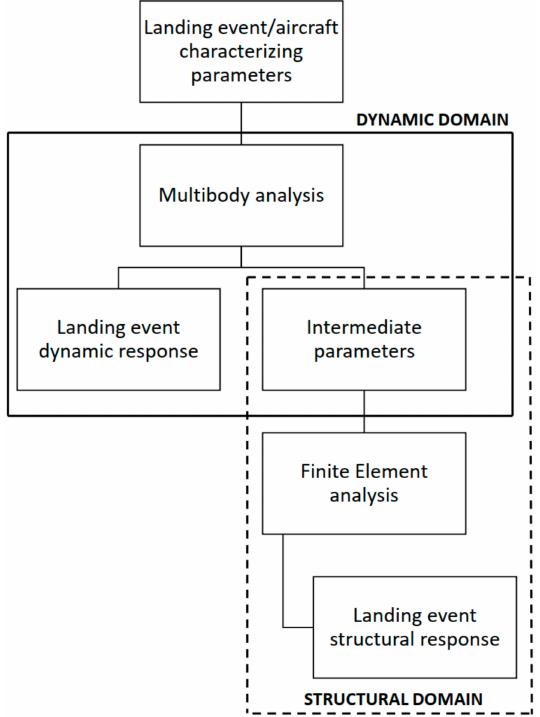
Figure 1. The “sequentially-coupled” method